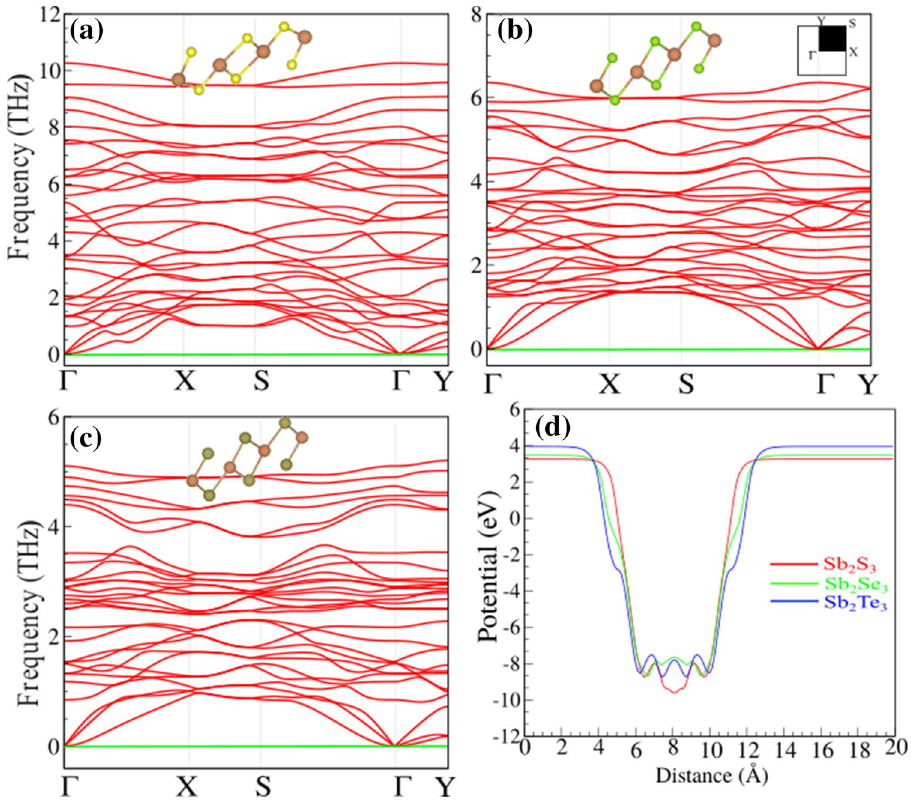
Figure 2. Phonon dispersions of ( a ) Sb 2 S 3 , ( b ) Sb 2 Se 3 and ( c ) Sb 2 Te 3 monolayers. Optimized atomic structure indicated as inset. ( d ) Electrostatic potential for the Sb 2 X 3 monolayers.